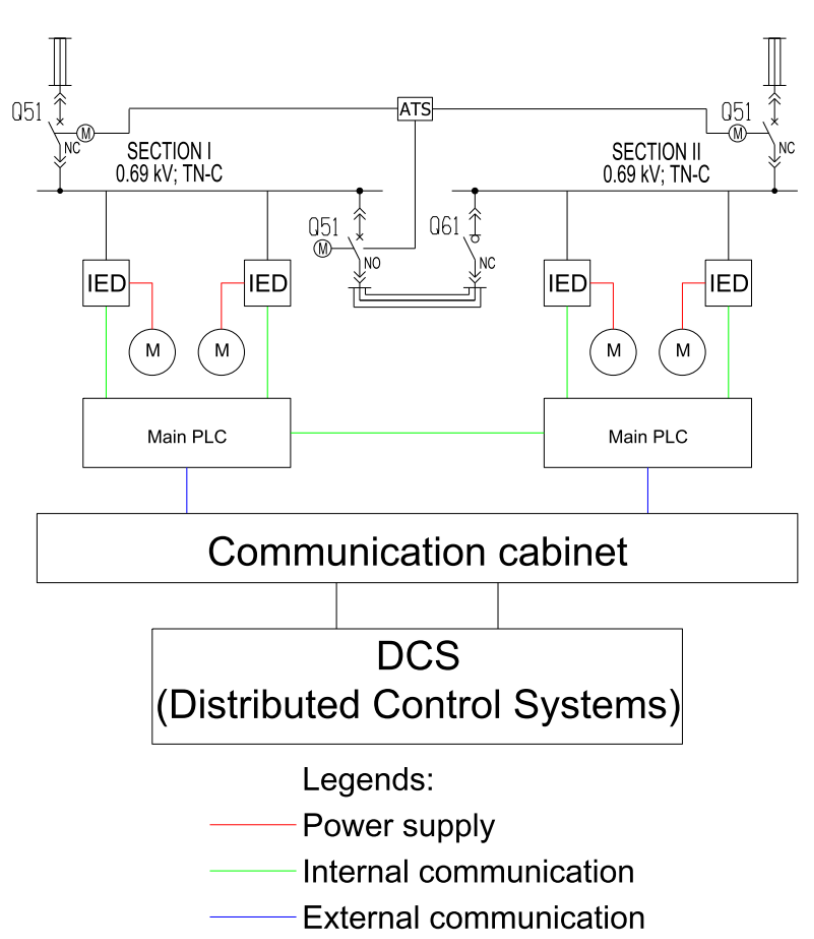
Figure 3. Topology of the indirect connection between the controller and the DCS supervision system via redundant PLCs (for systems with the highest system reliability). Table 1. Comparison of the three types of connection between PLC and DCS *.